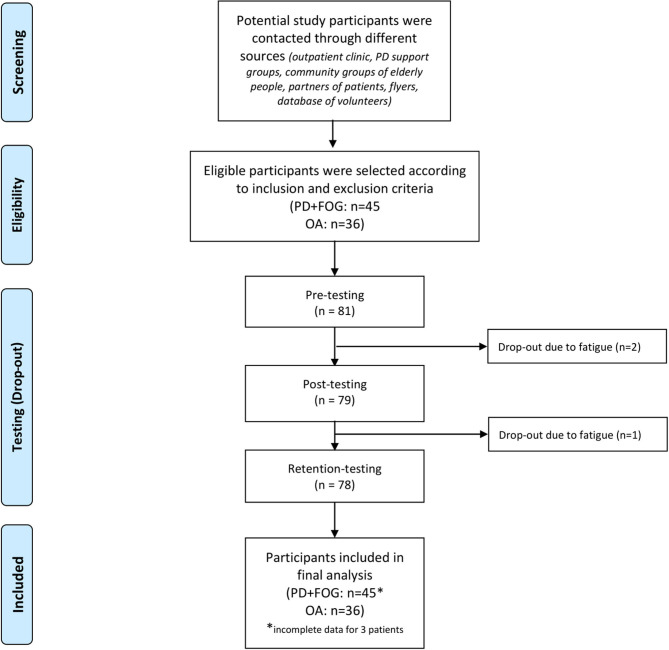
Flow diagram of recruitment process and study conduction; n, number of participants; PD+FOG, Parkinson's Disease with Freezing of Gait; OA, healthy older adults.